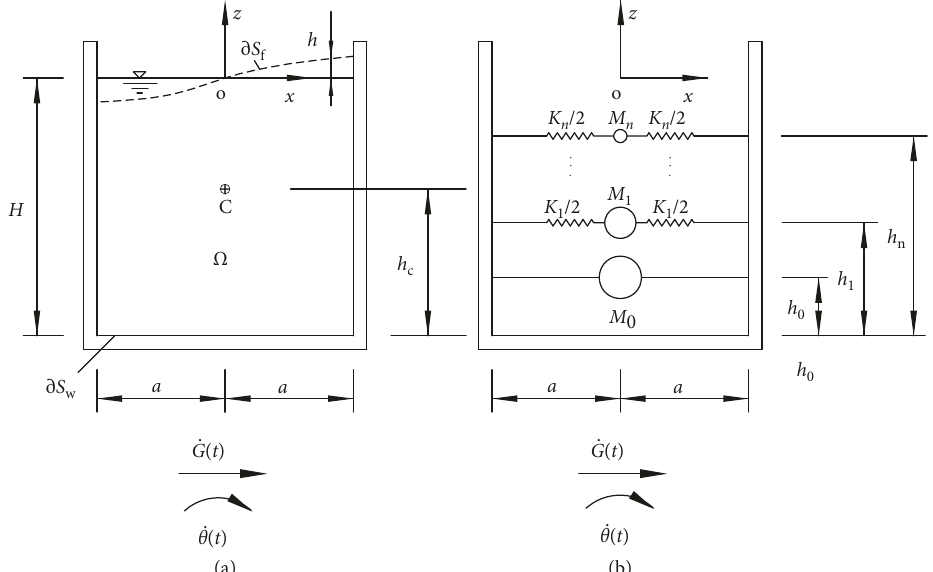
Figure 2: Fluid system and equivalent model. (a) Fluid system; (b) equivalent